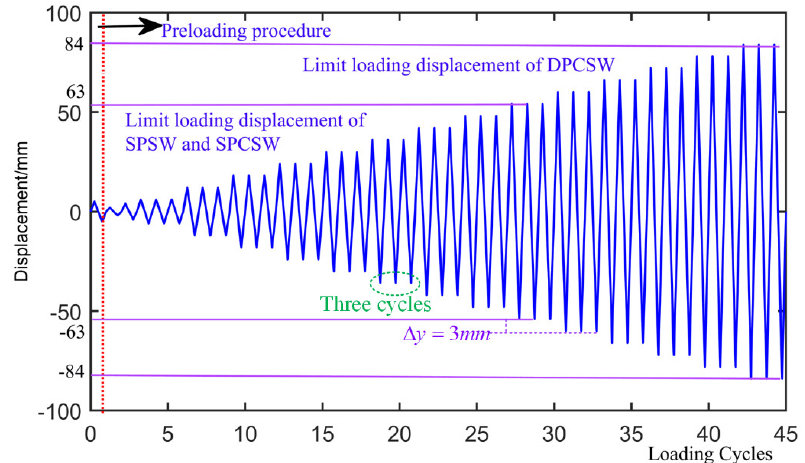
Figure 7. Loading systems of tested specimens.